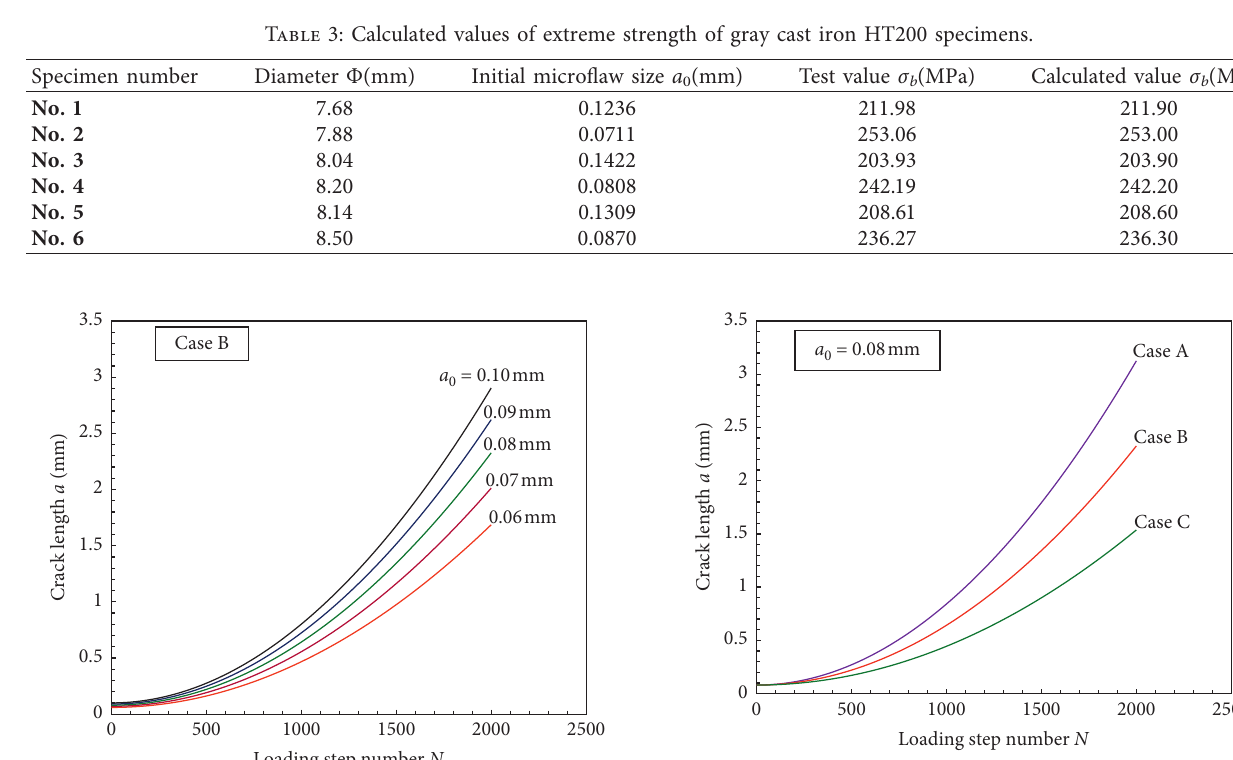
Figure 13: Crack length a versus loading step number N curves for different evolution paths of three scale transitional functions μ ∗ ( a ), σ ∗ ( a ), and d ∗ ( a